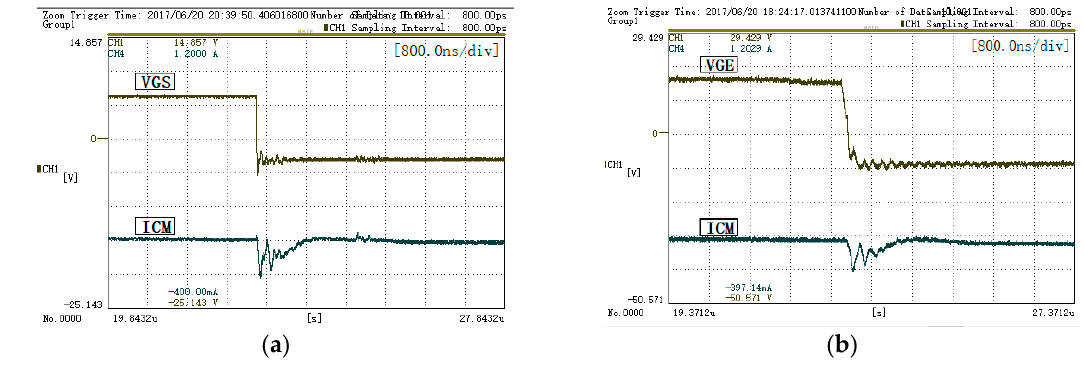
Figure 19. Turn-off common mode current. ( a ) GaN. ( b ) IGBT